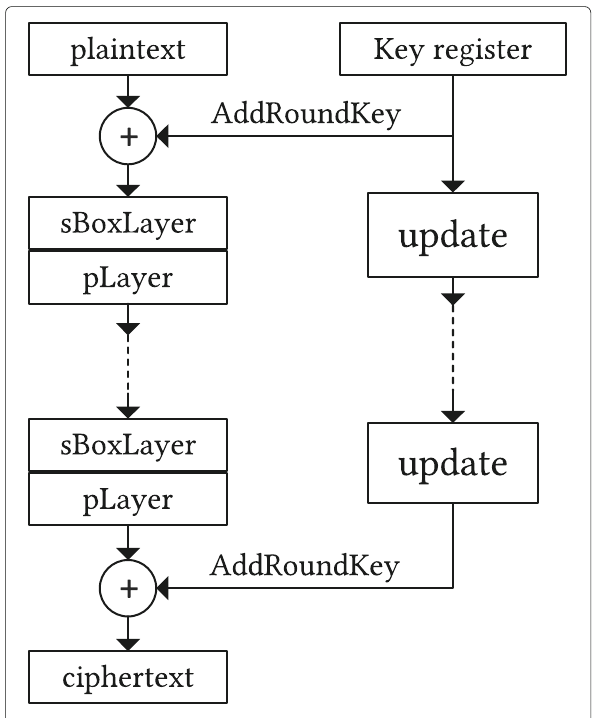
Fig. 5 The cipher description of PRESENT